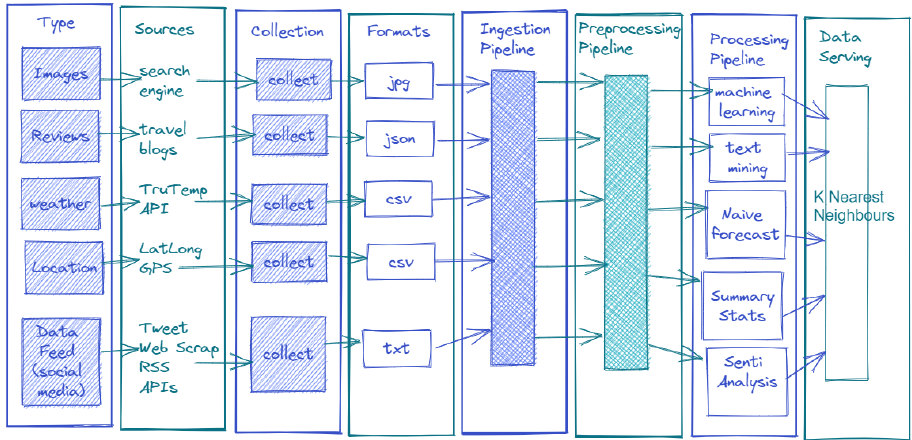
Figure 4. Augmented big data analytical model for TRS.